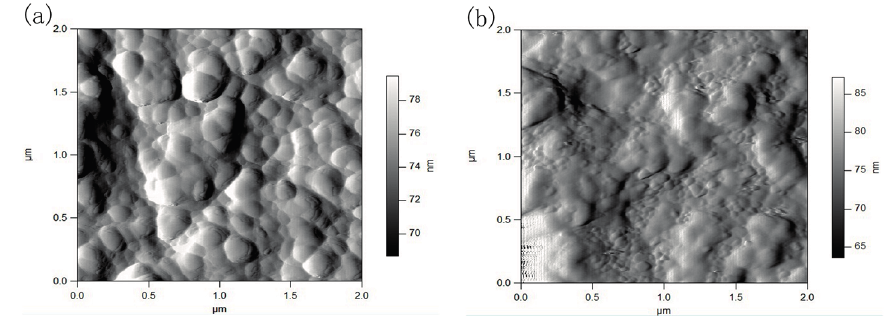
Figure 13. SEM graphs of P3HT-ZnO hybrid thin film stored after 15 days.